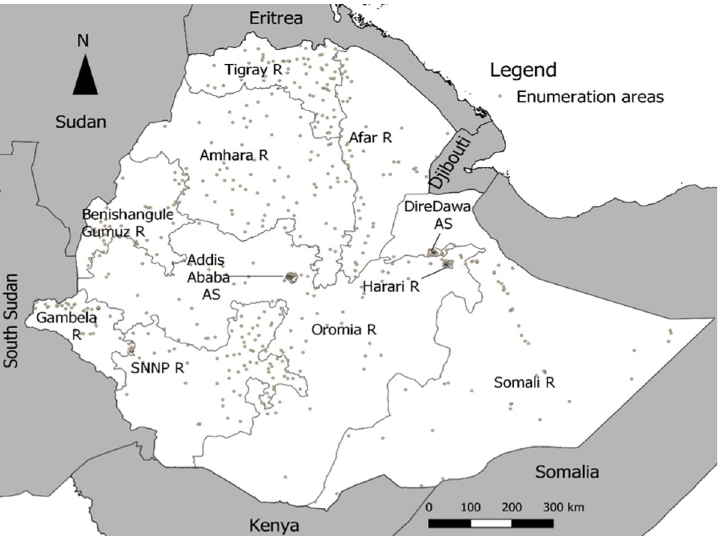
Fig 2. Map of Ethiopia with regions and administrative states. The enumeration areas have been randomly shifted, on average by 11 and 2 kilometers for rural and urban enumeration areas, respectively; R and AS stand for region and administrative state,